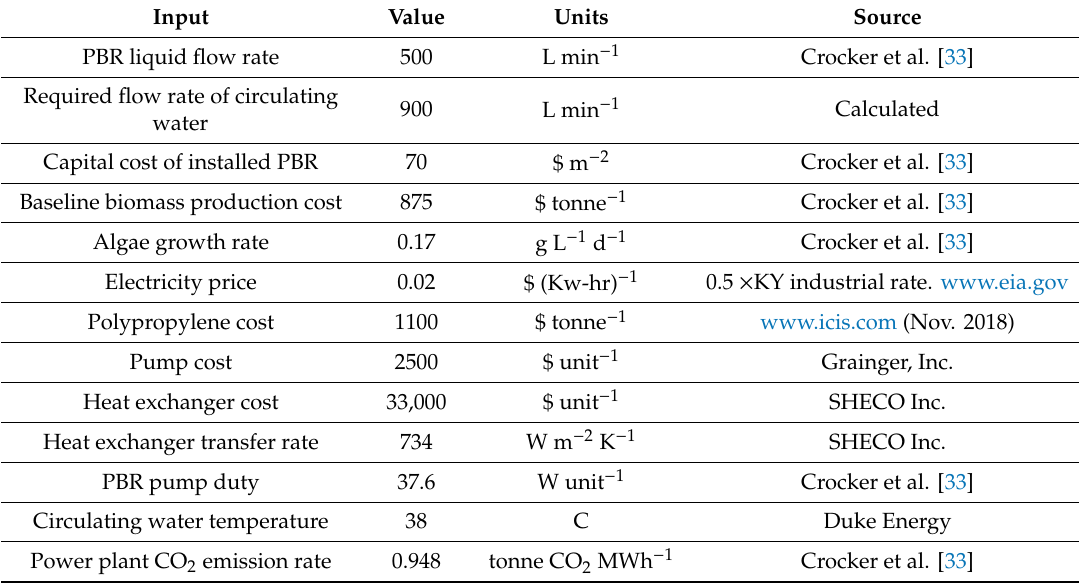
Table A1. Inputs and assumptions used when calculating increases in CAPEX and OPEX associated with heat